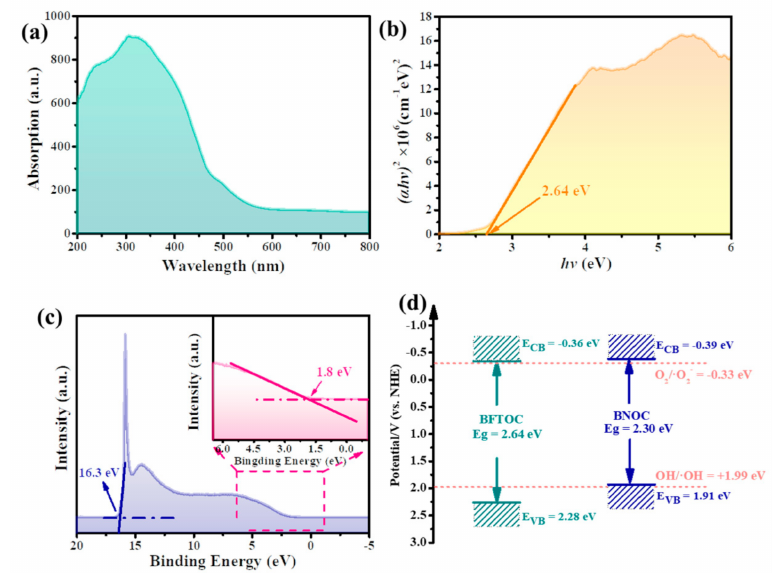
Figure 3. ( a ) UV-vis DRS spectrum of F-BFTOC; ( b ) Tauc’s band-gap plots of F-BFTOC; ( c ) VB XPS spectrum and energy-band alignment diagrams (insert) of F-BFTOC. ( d ) The band alignments of F-BFTOC and F-BNOC,